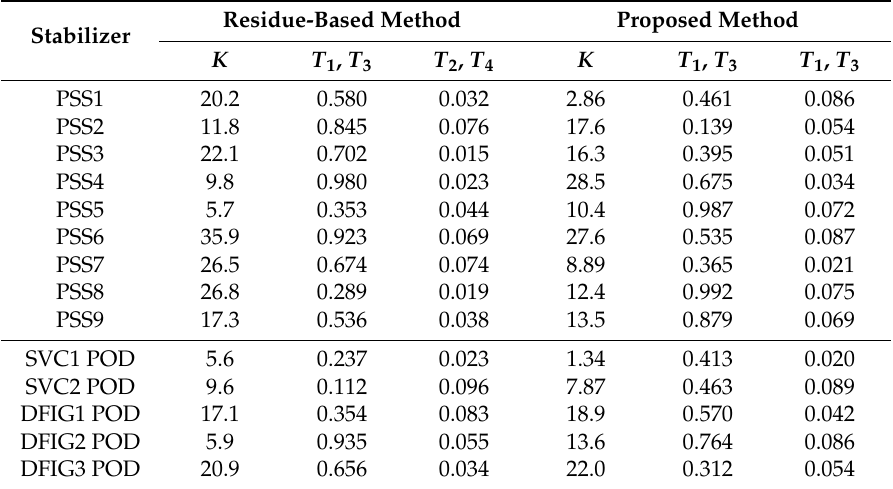
Table 8. Optimized parameters of PSSs and PODs.